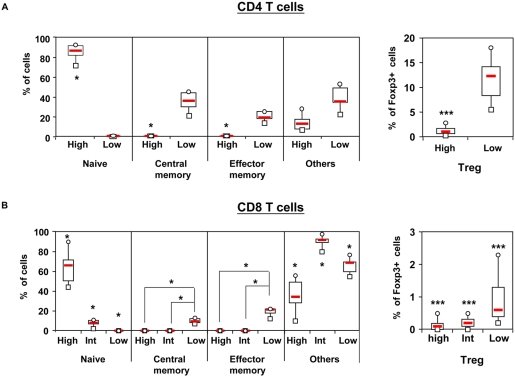
Phenotypic characterization of CD45RC T cell subsets.Peripheral blood leukocytes from healthy individuals were stained with mAbs against TCR, CD4 or CD8, CD45RC, CD45RA, CD45RO and CCR7 (n = 6) or TCR, CD45RC, CD4 or CD8 and Foxp3 (n = 27). Gates were set on CD4 T cells (upper panels) or CD8 T cells (lower panels). Box plot diagrams represent the proportion of naive (CD45RA+CD45RO−CCR7+), central memory (CD45RA−CD45RO+CCR7+), effector memory (CD45RA−CD45RO+CCR7−) and natural regulatory T cells (Foxp3+) within the CD45RC subsets. The group “others” contains both CD45RA+CD45RO−CCR7− and CD45RA+CD45RO+ subsets, subpopulations with ill defined functions. The p-values were calculated using the Wilcoxon matched-pairs test; *, p<0.05; **, p<0.02; p<0.002.